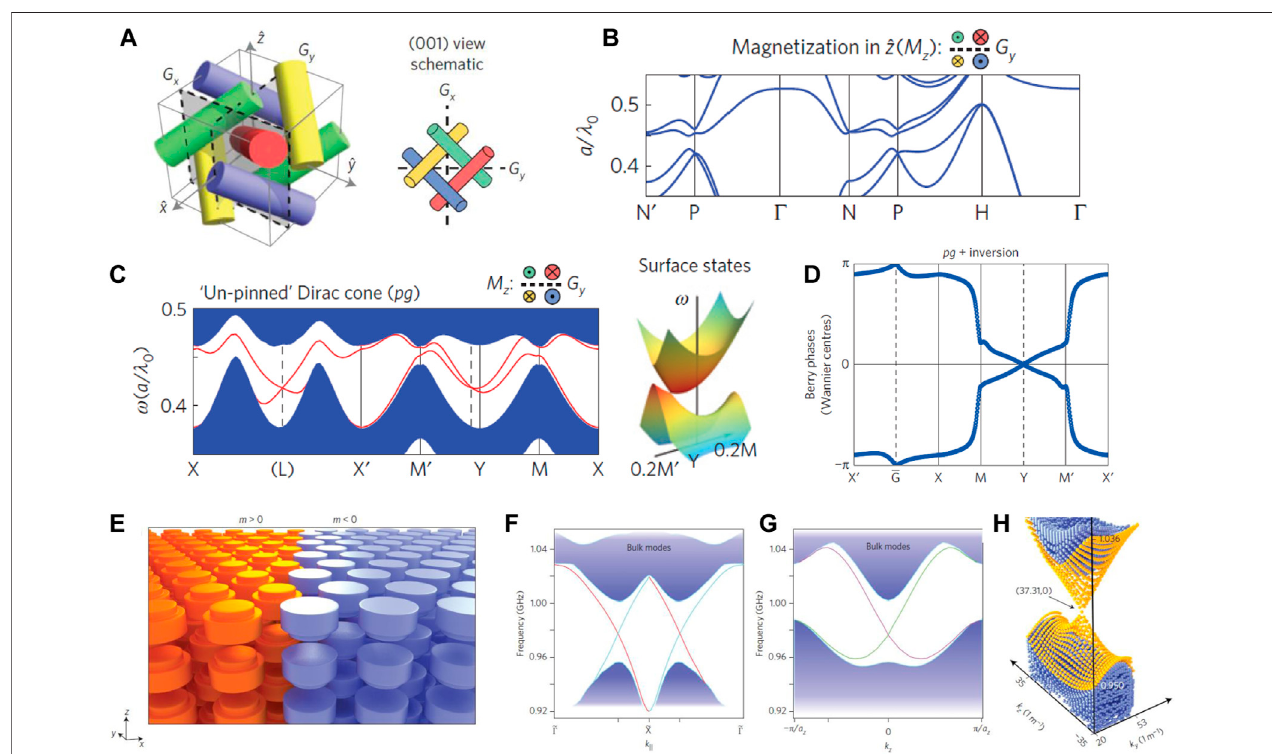
FIGURE 7 | Three-dimensional photonic topological insulators [58, 59]. (A) Three-dimensional all-dielectric PhCs with topological band gap. (B) Bulk band structure when magnetization is applied. (C) Single-surface Dirac cone in the M ′ − M line. (D) ) Gapless hybrid Wannier centers corresponding to the nontrivial surface states in (C) . (E) Schematics of the domain wall formed by the two 3D PTIs. (F, G) Band diagrams of topological surface states supported by the domain wall in (E) with 2D cut-planes (F) ω - k || and (G) ω - k z , respectively. (H) Conical Dirac-like dispersion of the surface states. Reproduced permission from Refs. 58,